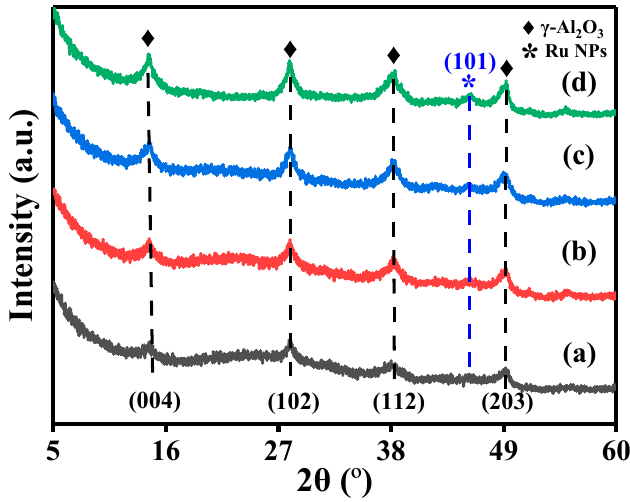
Figure 1. XRD pattens of (a) γ -Al 2 O 3 , (b) γ -Al 2 O 3 @ASMA, (c) 5%Ru/ γ -Al 2 O 3 @ASMA, and (d) 5%Ru/ γ - Al 2 O 3 .